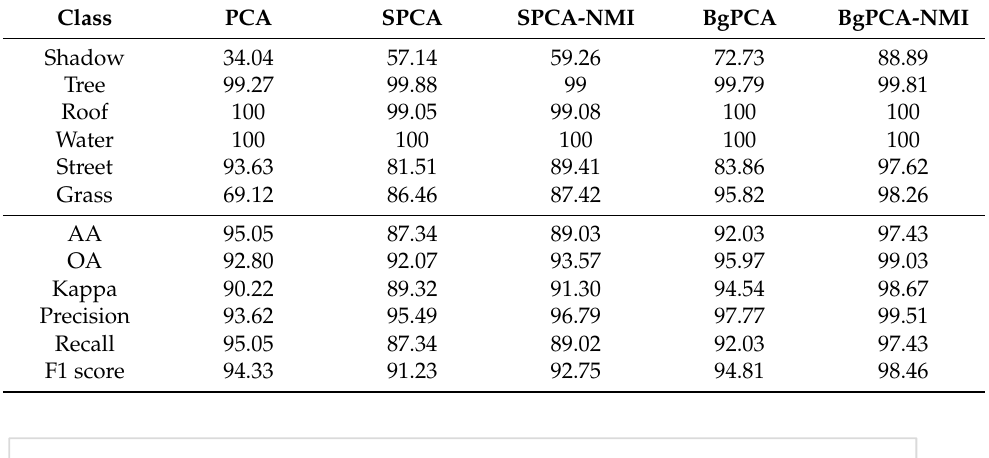
Table 6. Detailed classification outcomes for the Washington DC Mall dataset.